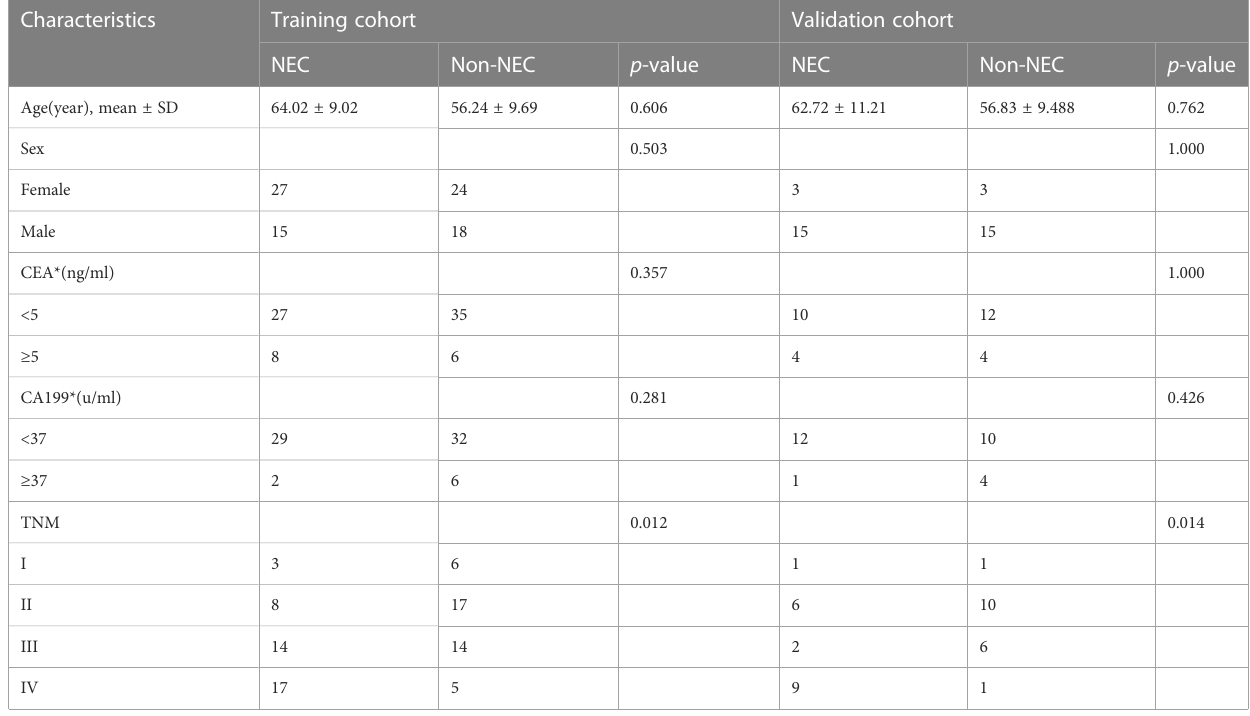
TABLE 1 Patient clinical characteristics in the training and validation cohorts.